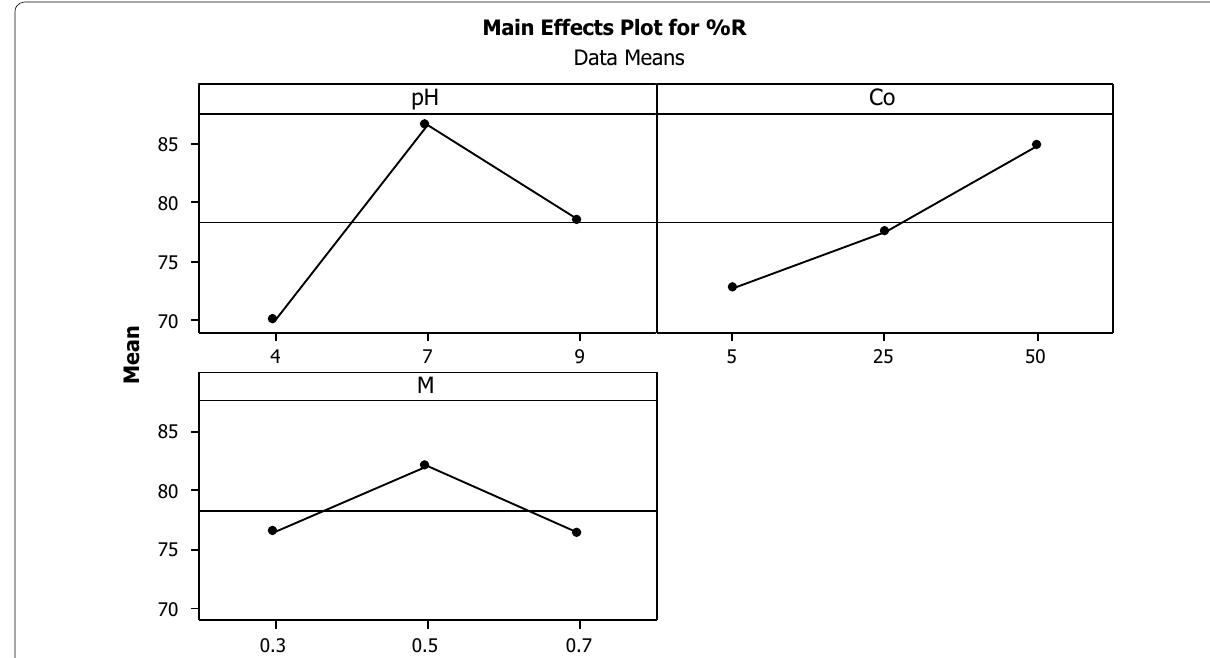
Fig. 3 Main effects of each parameter on the bisacodyl adsorption process, initial concentration had a strong positive effect on adsorption process. The pH of 7 was the optimum for removal of bisacodyl and the adsorbent dose had a similar effect on the removal